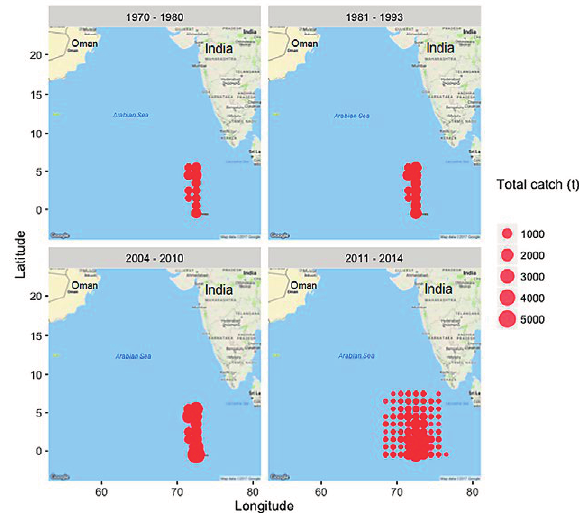
Fig. 6. – Space-time distribution of the total catch by time period in the Maldives.